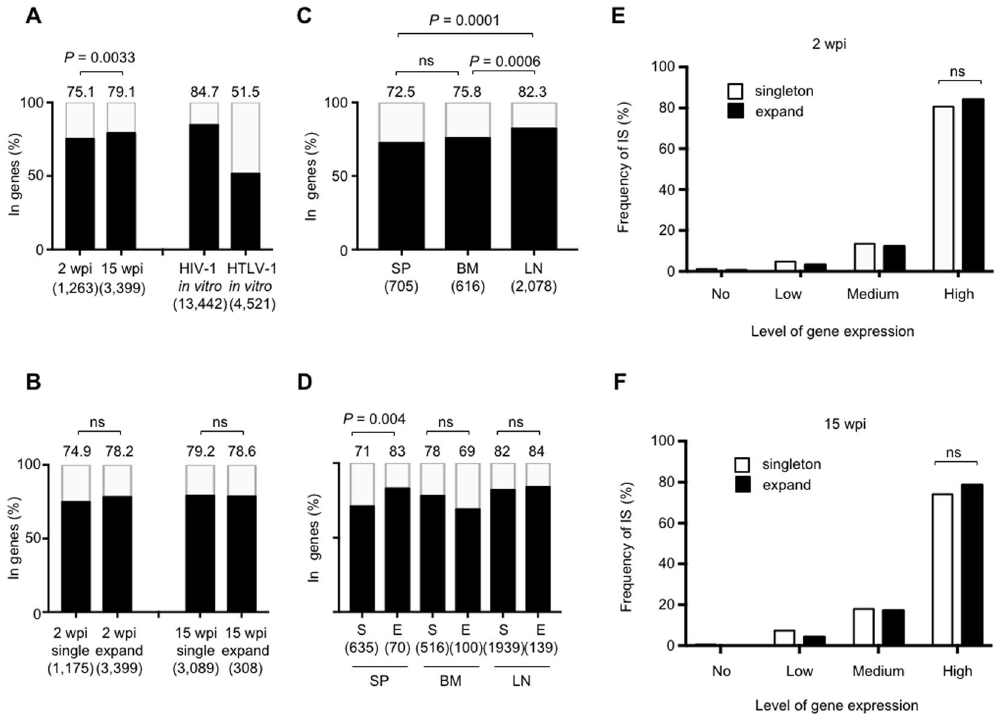
Figure 4. Relationship between HIV-1 integration sites and the host genes. ( A ) Frequencies of the integration sites located in genes in 2 wpi or 15 wpi mice are shown in the bar graph. Jurkat cells infected with HIV-1 or HTLV-1 in vitro were used as controls. ( B ) Comparison of the frequency of expanded and singleton clone in 2wpi and 15 wpi mice. ( C ) Frequencies of integration sites within genes are shown for different tissues. ( D ) Comparison of the frequency between expanded and singleton clones in different tissues. S: singleton clones, E: expanded clones. Numbers above the graph indicate the percentage. The number of infected cells or clones in each sample is shown under the graph. ( E , F ) Relationship between integration sites and level of expression of the corresponding host genes in 2 and 15 wpi mice. The cumulative results from different tissues of 2 wpi mice ( E ) and 15 wpi mice ( F ) are shown in the bar graphs. ns: no significant